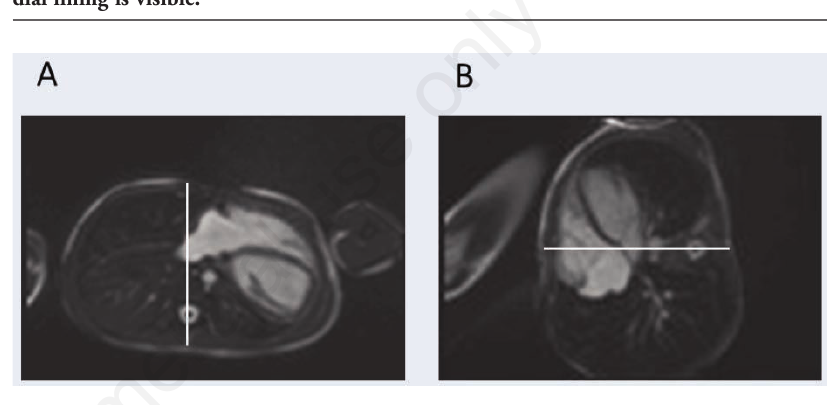
Figure 2. Cardiac Magnetic Resonance Imaging performed in dorsal decubitus (A) and in right lateral decubitus (B). The sequence is acquired in steady-state free precession. The white line represents the anterior-posterior axis of the thorax. It allows the estimation of the rightward cardiac displacement in right lateral position.